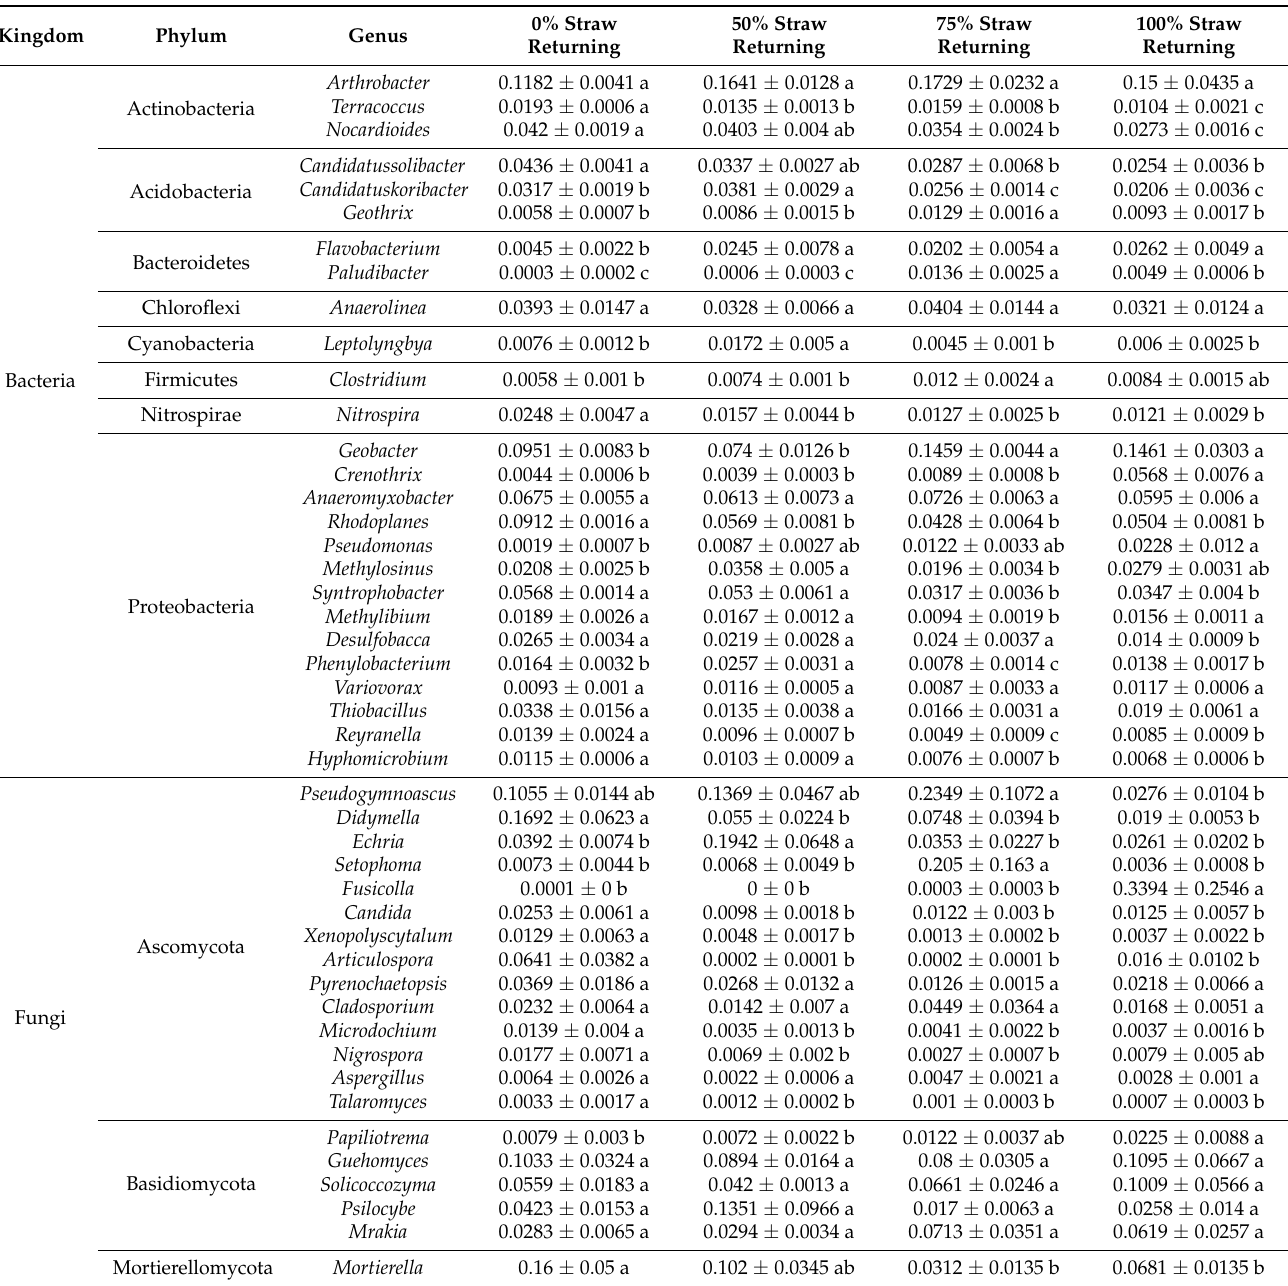
Table 3. Relative abundance of bacteria and fungi at the genus level in paddy soil with different levels of straw